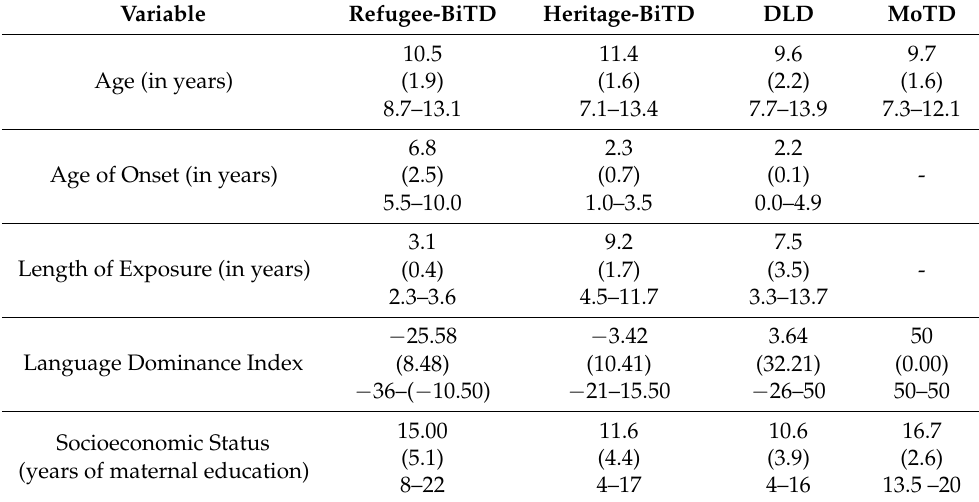
Table 1. Participant overview (mean, SD,